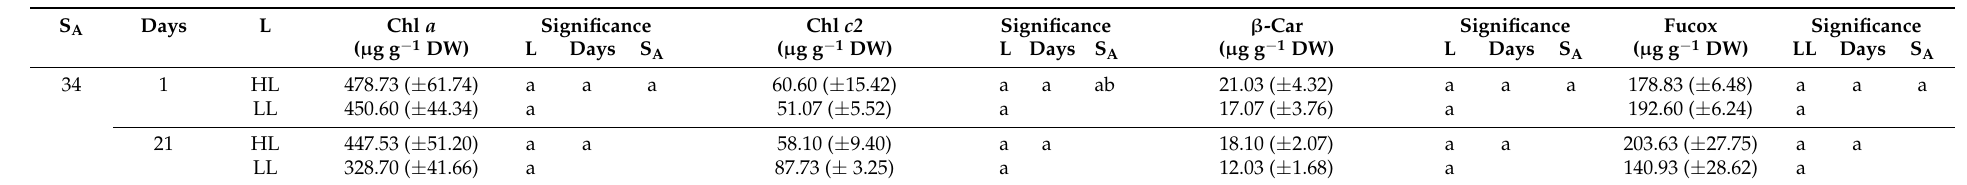
Table 2. Concentration of main pigments [ µ g g − 1 dry weight (DW)] of Desmarestia aculeata : Chl a , Chl c2 , β -Car, Fucox. Experimental set-up: salinity (S A )–Light (L) (High Light (HL)–Low Light (LL)) treatments. Values are means ± SD (n = 3). For each parameter (L, Days, S A ), statistically significant differences are marked by different lowercase letters. For all the data, three-way ANOVA with post-hoc Tukey’s test was performed ( p <